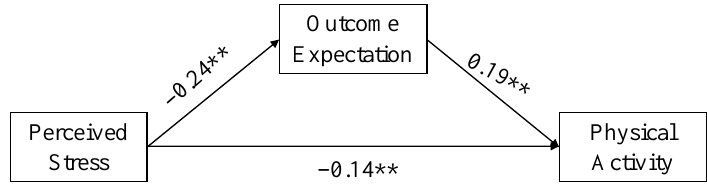
Figure 2. The mediating effect of outcome expectancies. ** p < 0.01.